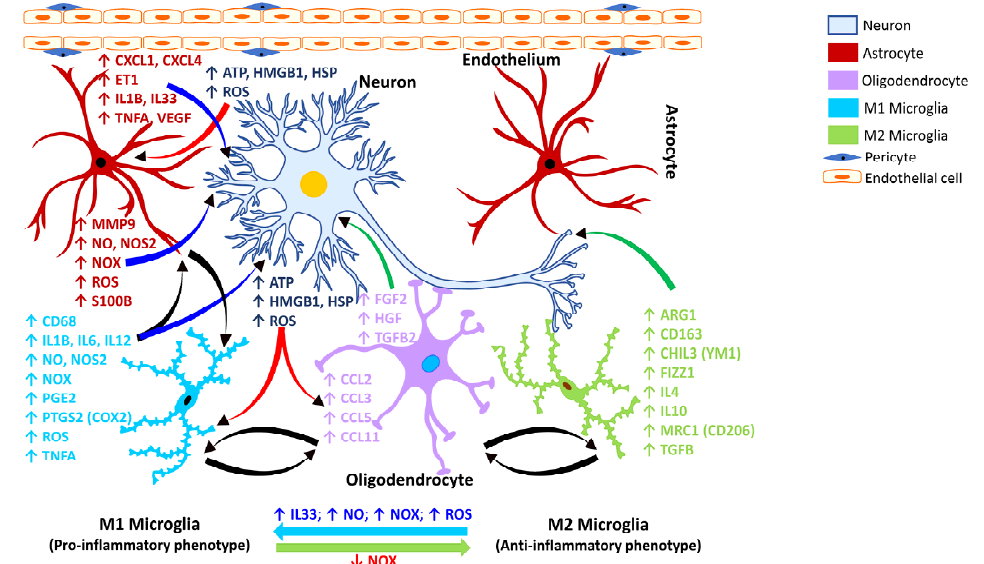
Figure 1. Inflammatory mechanism in traumatic brain injury. Schematic representation of the molecular mechanisms associated with glia-mediated functional interactions and systematic perturbations within the CNS to induce neuroinflammation in traumatic brain injury. The endothelial cells form the inner lining of the blood vessel with pericytes enveloping the surface of the vasculature forming tight junctions to maintain the BBB integrity. Upon insult, neurons release danger/damage signals that cause activation of neighboring glial cells. M1 microglia (proinflammatory phenotype, neurotoxic) release various proinflammatory mediators including free radicals, cytokines, and chemokines that further stimulate other glial cells and collectively contribute to exacerbating the neuronal injury/damage. M2 microglial cells (anti ‐ inflammatory phenotype, neuroprotective) can polarize to an M1 state and release proinflammatory mediators in the presence of increased levels of NOX, ROS, NO, and IL33 released by M1 microglia and/or astrocytes and thereby augment the neuroinflammatory and neuronal injury process leading to synaptic dysfunction, neuronal injury, and neuronal death. Astrocytes respond by releasing proinflammatory mediators including free radicals, cytokines, and chemokines, which further contribute to enhancing the endothelial perme ‐ ability, disrupting BBB integrity, and allowing for infiltration of peripheral immune cells, events that further intensify inflammation and neuronal injury. Feedback regulation of NOX or its inhibi ‐ tion causes M1 microglia to polarize to the M2 state (anti ‐ inflammatory phenotype), which down ‐ regulates M1 functions and promotes regulation of neuroinflammation and neurorepair by releas ‐ ing anti ‐ inflammatory mediators, e.g., cytokines, neurotrophic, and growth factors. Mediators re ‐ leased by specific neural cell types (neuron, astrocyte, microglia, or oligodendrocyte) are listed ad ‐ jacent to each cell type in similar colored text. Curved arrows indicate the direction of signal flow between various neural cells for the inflammation activation process. Red curved arrows show the directional flow of danger/damage signals from neurons to glial cells (astroglia, microglia, oligoden ‐ droglia); blue curved arrows show the flow of proinflammatory signals from astrocytes and M1 microglia towards distressed neurons; green curved arrows show the flow of neurotrophic signals from M2 microglia and oligodendroglia towards the distressed neurons as a neuroprotective/neu ‐ rorescue endeavor; black curved arrows show the directional crosstalk among various glial cells to mount a glial response to neuronal injury/damage. ↑ , increase; ↓ , decrease; ARG1, arginase 1; ATP, adenosine triphosphate; BBB, blood ‐ brain barrier; CCL2, C ‐ C motif chemokine ligand 2 (also re ‐ ferred to as MCP1, monocyte chemoattractant protein 1); CCL3, C ‐ C motif chemokine ligand 3; CCL5, C ‐ C motif chemokine ligand 5; CCL11, C ‐ C motif chemokine ligand 11; CD68, CD68 mole ‐ cule; CD163, CD163 molecule; CHIL3, chitinase ‐ like protein 3 (also referred to as YM1);; CXCL1, C ‐ X ‐ C motif chemokine ligand 1; CXCL4, C ‐ X ‐ C motif chemokine ligand 4; ET1, endothelin 1; FGF2, fibroblast growth factor 2; FIZZ1, found in inflammatory zone 1; HGF, hepatocyte growth factor; HMGB1, high ‐ mobility group box 1; HSP, heat shock proteins; IL1B, interleukin 1 beta; IL4, inter ‐ leukin 4; IL6, interleukin 6; IL10, interleukin 10; IL12, interleukin 12; IL33, interleukin 33; MMP9, matrix metalloproteinase 9; MRC1, mannose receptor C ‐ type 1 (also referred to as CD206); NO,